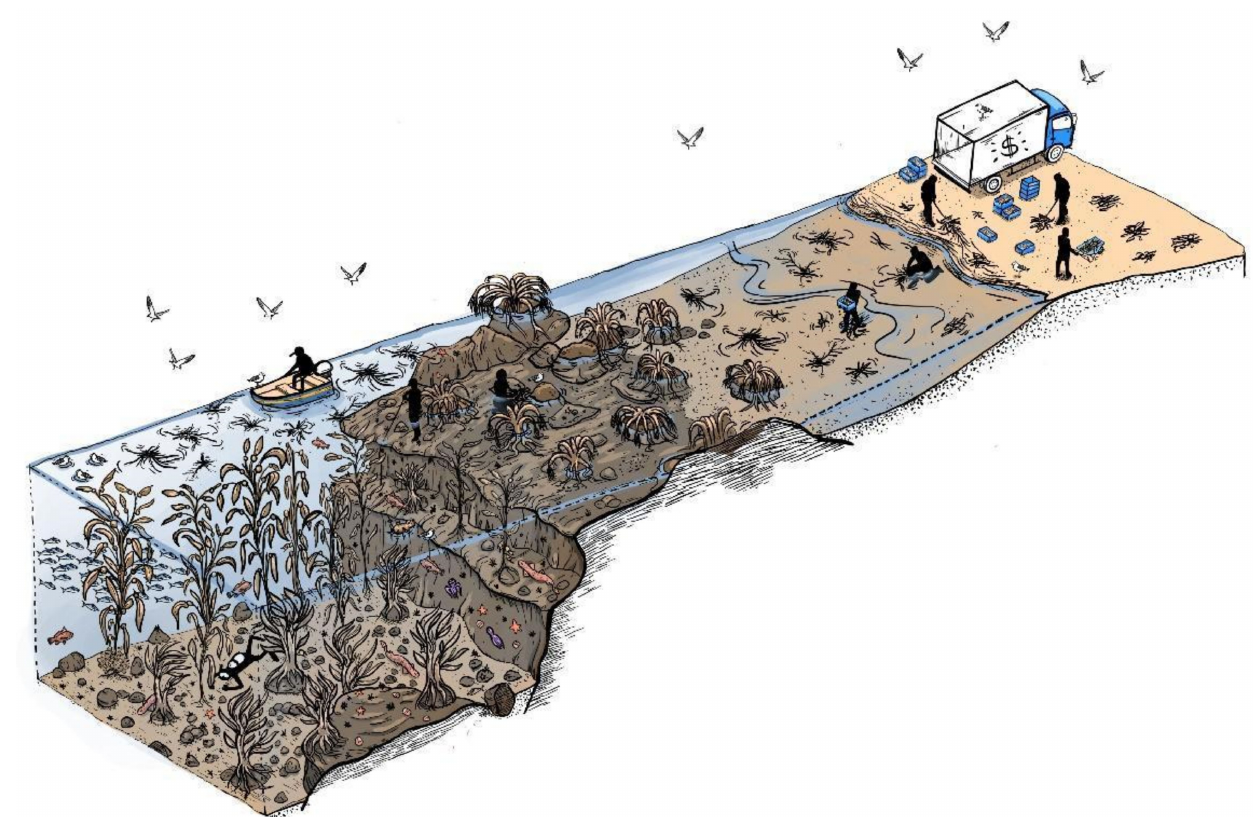
Figure 6. The laminarian assemblages of the HCS are distributed in the intertidal and subtidal areas of rocky shores. They bring coastal protection and structure a habitat for a plethora of threatened and commercial species, allowing them a place to shelter, feed and reproduce, as their fragments help disperse the larvae of organisms associated (Supporting and Regulating Service). The forests have a key role as a blue carbon reservoir and the carbon flux through the sandy beach (Regulating Service). In addition, these coastal hotspots on the coast are key ecosystems for different human activities, mainly fishing directly or recollected (shipped and non-shipped), tourism (diving, recreational fishing, boat sailing), and scientific research (Providing and Cultural